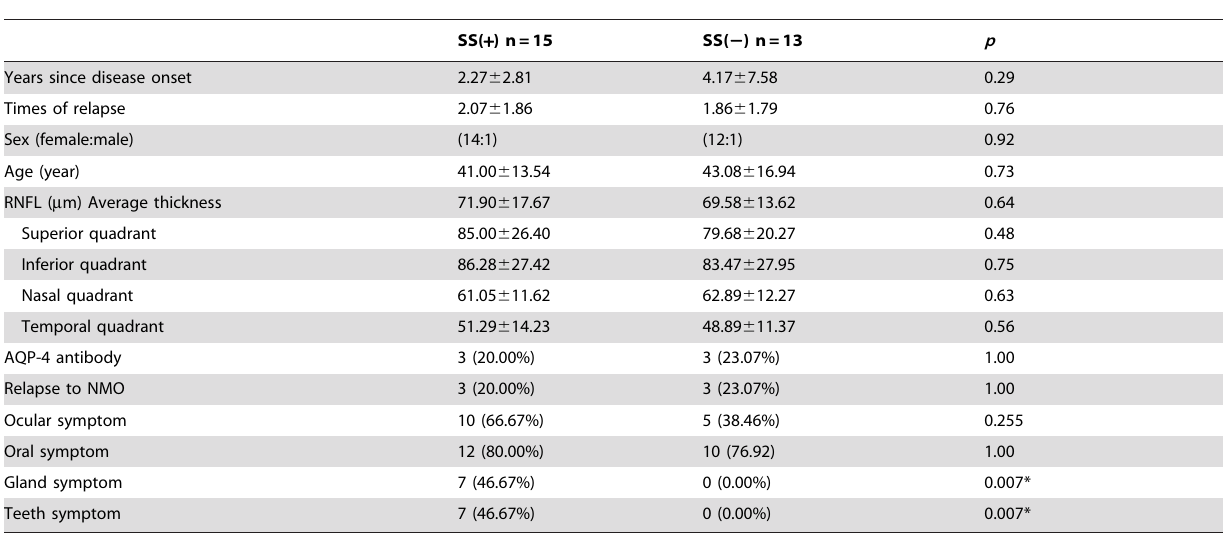
Table 5. Differences between patients with SS and positive SSA/SSB but not SS diagnosis.